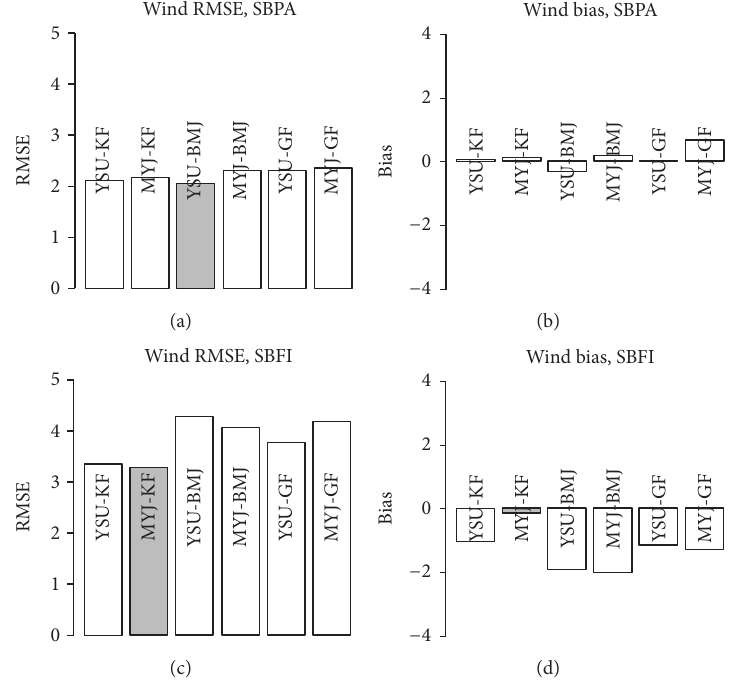
Figure 10: As in Figure 8 but for the simulated wind profiles at SBPA [(a)-(b)] and SBFI [(c)-(d)]